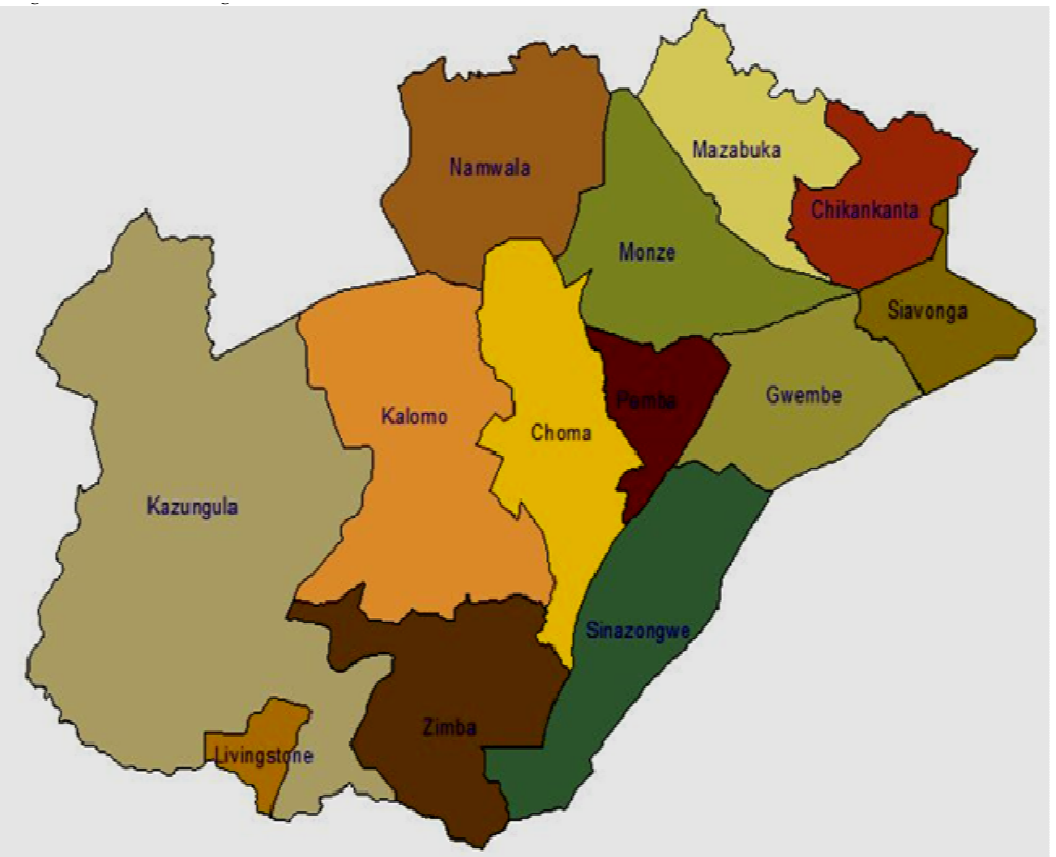
Figure 1. Study location—Choma and Pemba districts in Southern Zambia. (Source: Ministry of Agriculture, Zambia).